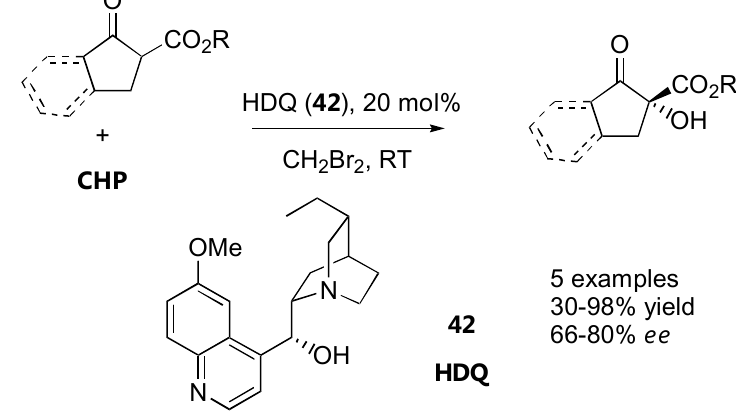
Figure 33. Organocatalyzed  -oxidation of cyclic  -ketoesters with hydroperoxides [127].